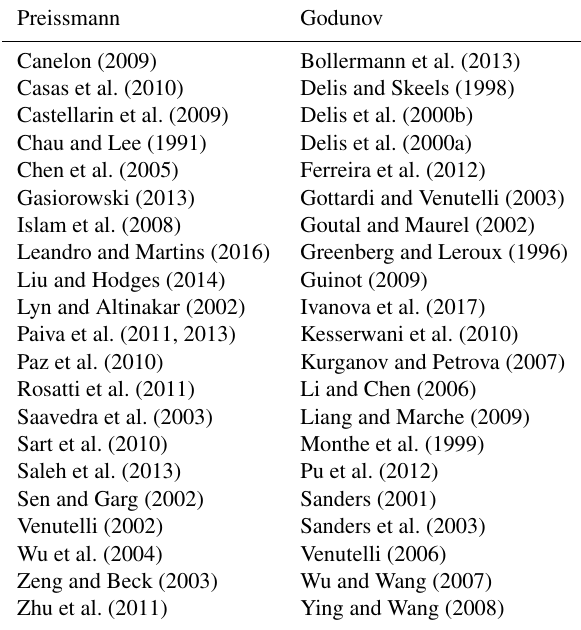
Table 1. Two decades of Preissman vs.